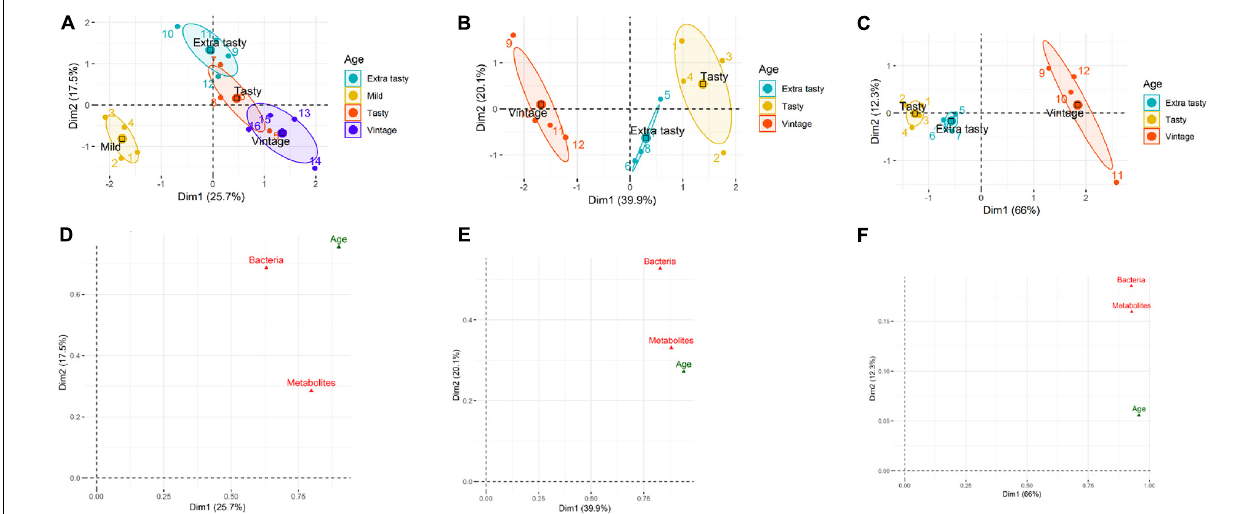
FIGURE 4 | Multifactorial analysis (MFA) of cheese microbiota and cheese metabolite profiles for cheeses of different maturities from different manufacturers (A, B, and C). (A–C) MFA scatter plots for cheeses from brands A, B, and C, respectively. Ellipses representing the barycentre of the sample groups with 95% confidence. Maturity (age) of chesses is as indicated. (D–F) MFA group representations to illustrate the relationships between variables (bacterial genus composition, metabolite profiles, maturity of cheeses) and Dim 1and Dim 2 for brands A, B, and C,